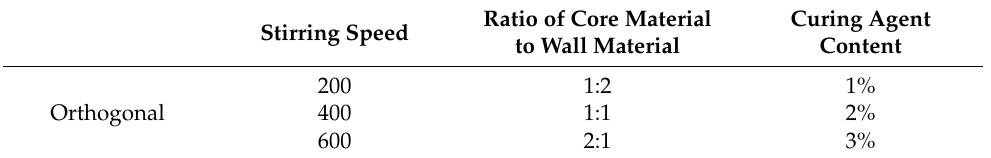
Table 1. Summary of experimental